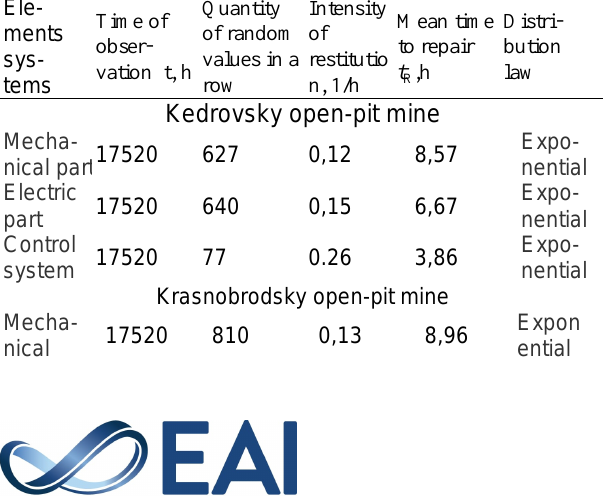
Table 2. The distribution law parameters of a time per fault of rope shovel electromechanical system